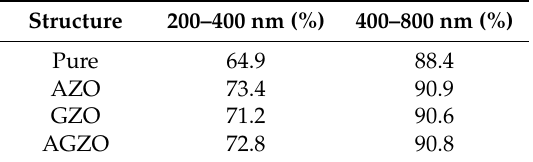
Table 4. Average transmittance of Al/Ga ‐ doped ZnO in the UV and visible light regions.